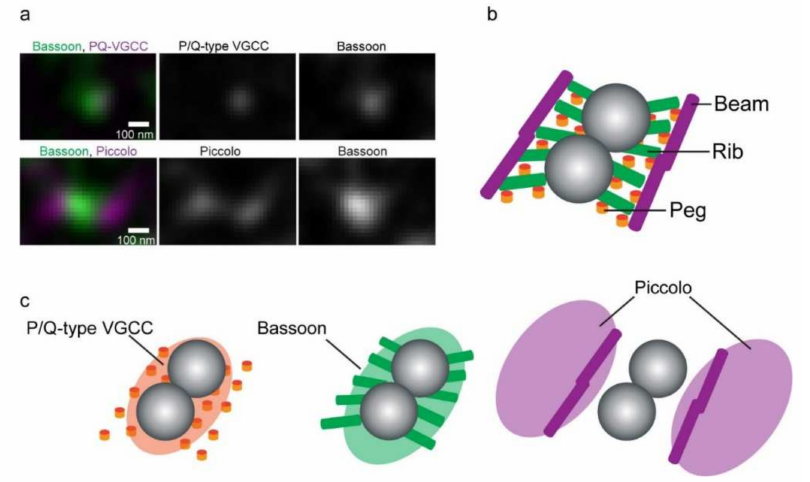
Figure 4. Active zone proteins and structure of mouse NMJs. ( a ) Dual-color STED micrographs show an overlap of Bassoon (green) and P/Q-type VGCCs (magenta) and the side-by-side distribution